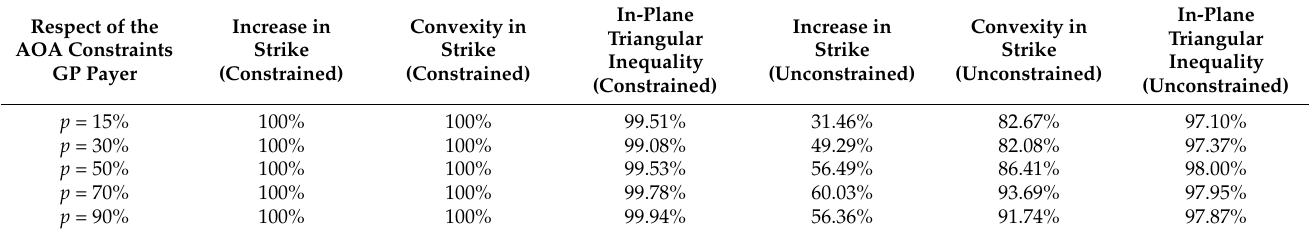
Table 4. Respect of the no-arbitrage constraints for the predicted OTM receiver swaptions priced by constrained and unconstrained GP regression, for increasing sizes of training set.